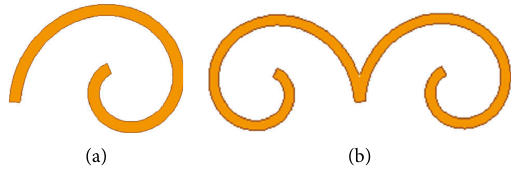
Figure 3: (a) Archimedes spiral structure; (b) cloud-like structure.